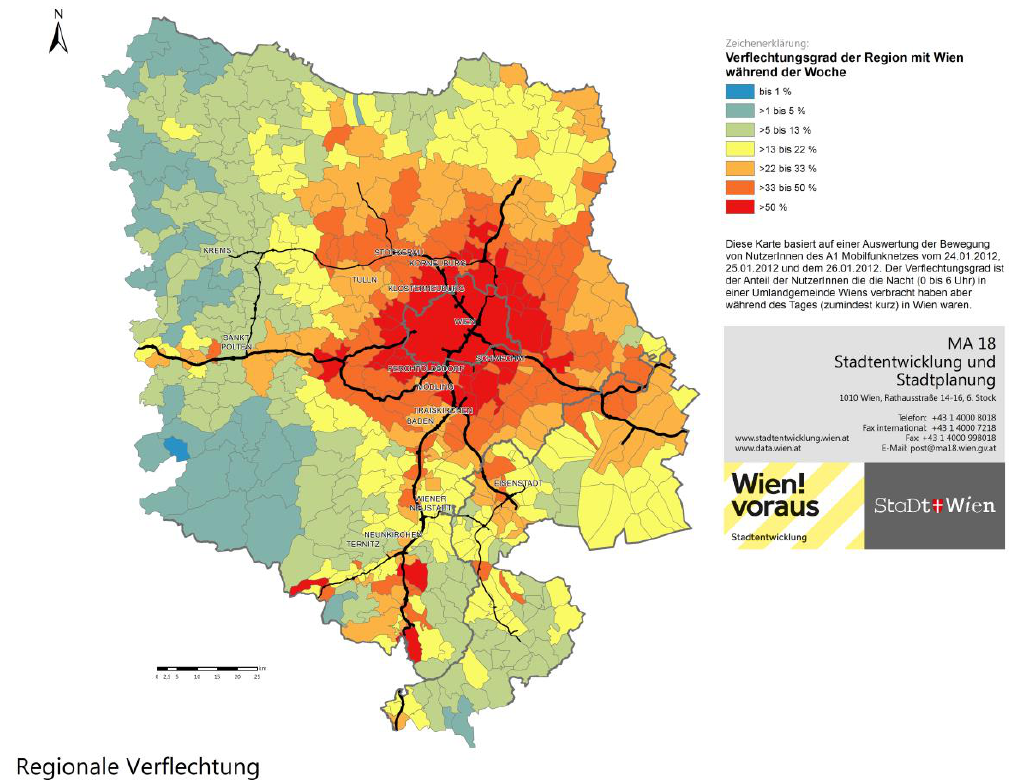
Figure 11. City-region regional interaction pattern mapping using Mobility Explorer (German labels are used to support local language).